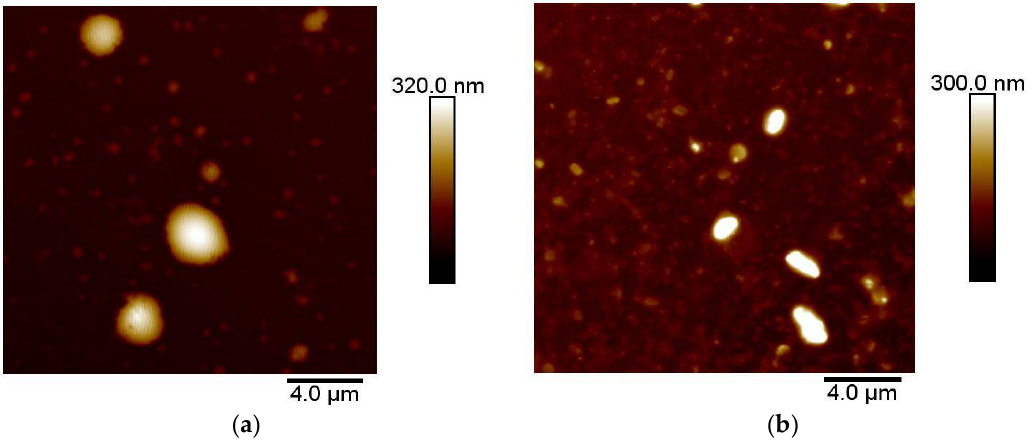
Figure 7. Microscopic images using AFM. ( a ) CG-Nio with mucin, and ( b ) CG-NioP with mucin.